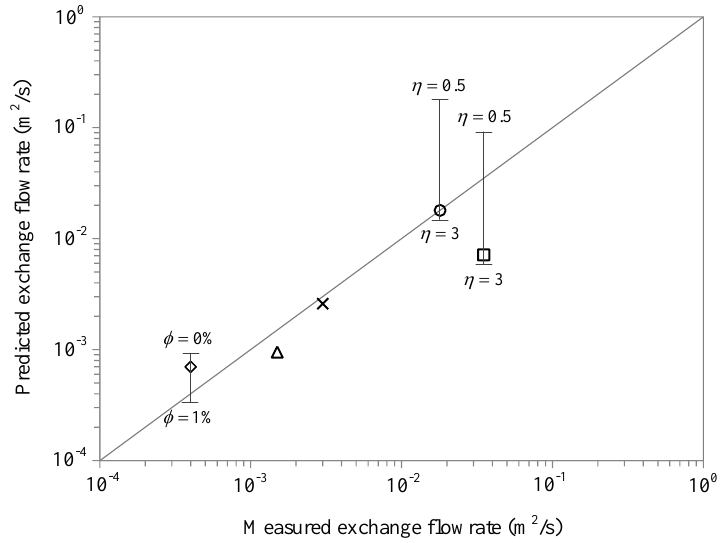
Table 1. Relevant parameters for field measurements. Figure 9. This is a figure. Schemes follow the same formatting. Comparisons of horizontal exchange flowrates between the prediction solution and measurements. “ ” and “ ” are data from [1]; “ ” is from [32]; “ ” and “ ” are from [16] and [9], respectively.